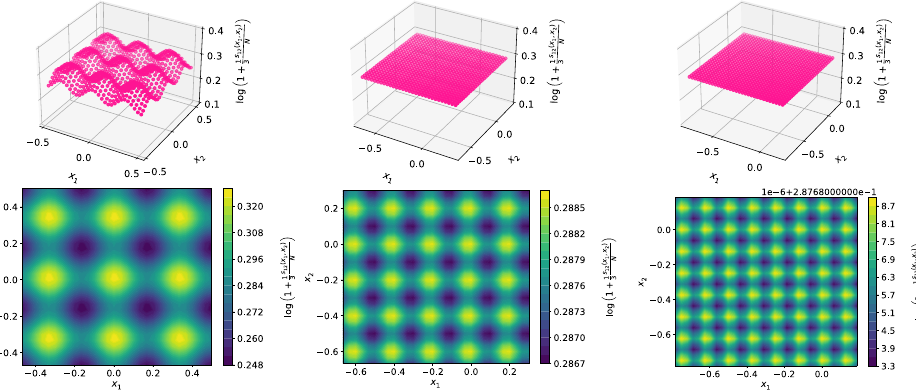
Figure 2. We display as a function of x 1 /l and x 2 /l the profiles obtained by integrating the action density over x and x . The unit of length is set by taking l = 1 . Gauge groups are, 0 3 from left to right: SU(3) , SU(5) and SU(8) . For readability of the plots, the quantity displayed is log (cid:0) 1 + l 2 s ( x ) / (3 N ) (cid:1) . In the large N limit the profile approaches the one of the constant 12 1 , x 2 curvature solution for which log(1 + 1 / 3) = 0 . 287682